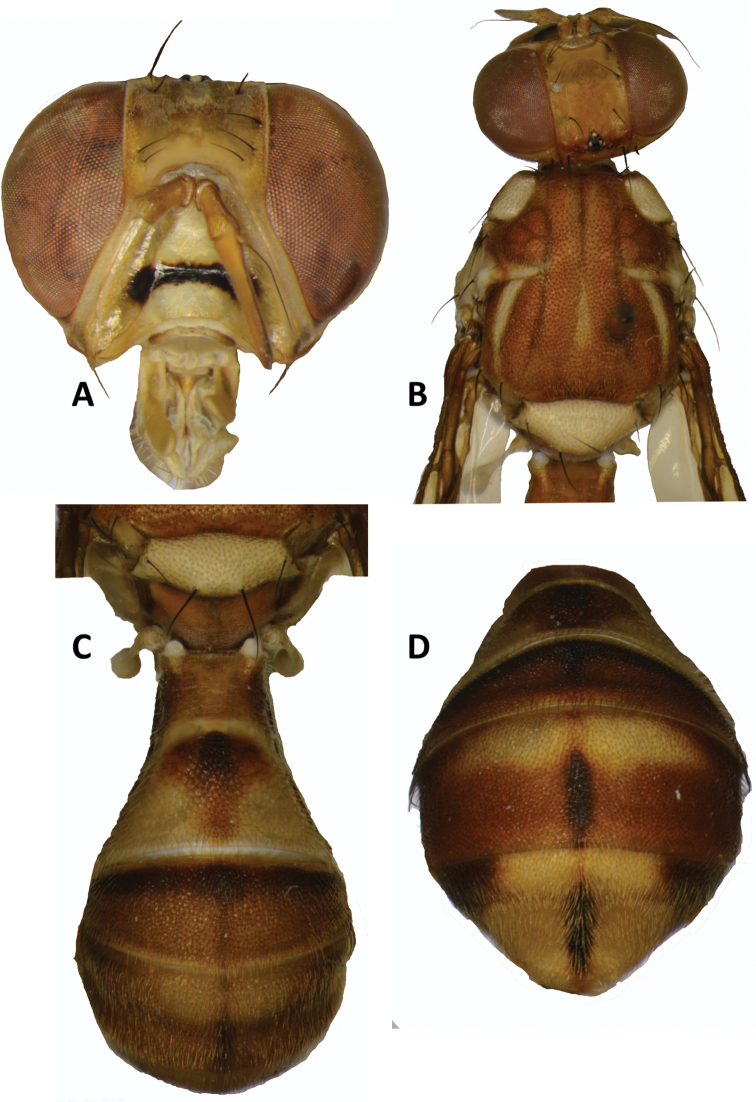
Zeugodacus
madhupurisp. nov.A head B head and scutum C–D abdomen.